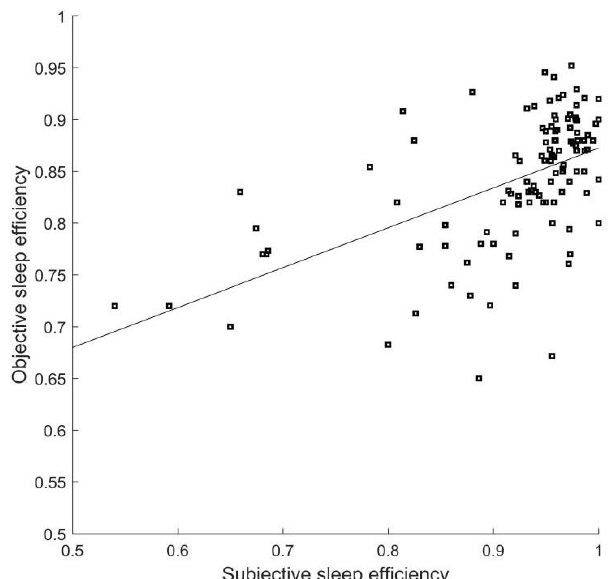
Figure 7. Corresponding relationship between subjective and objective sleep efficiency (Each spot represents a subject. The straight line is their least-square fitting curve).